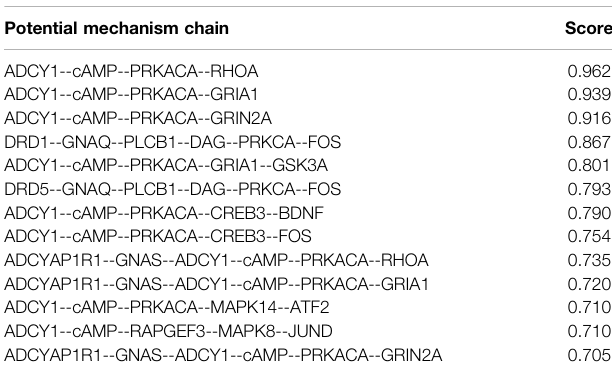
TABLE 4 | Cascade pathways predicted by the MTW